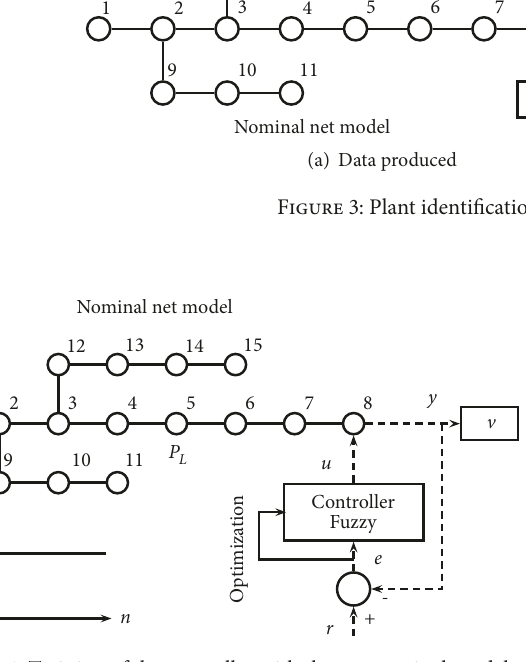
Figure 4: Training of the controller with the net nominal model.